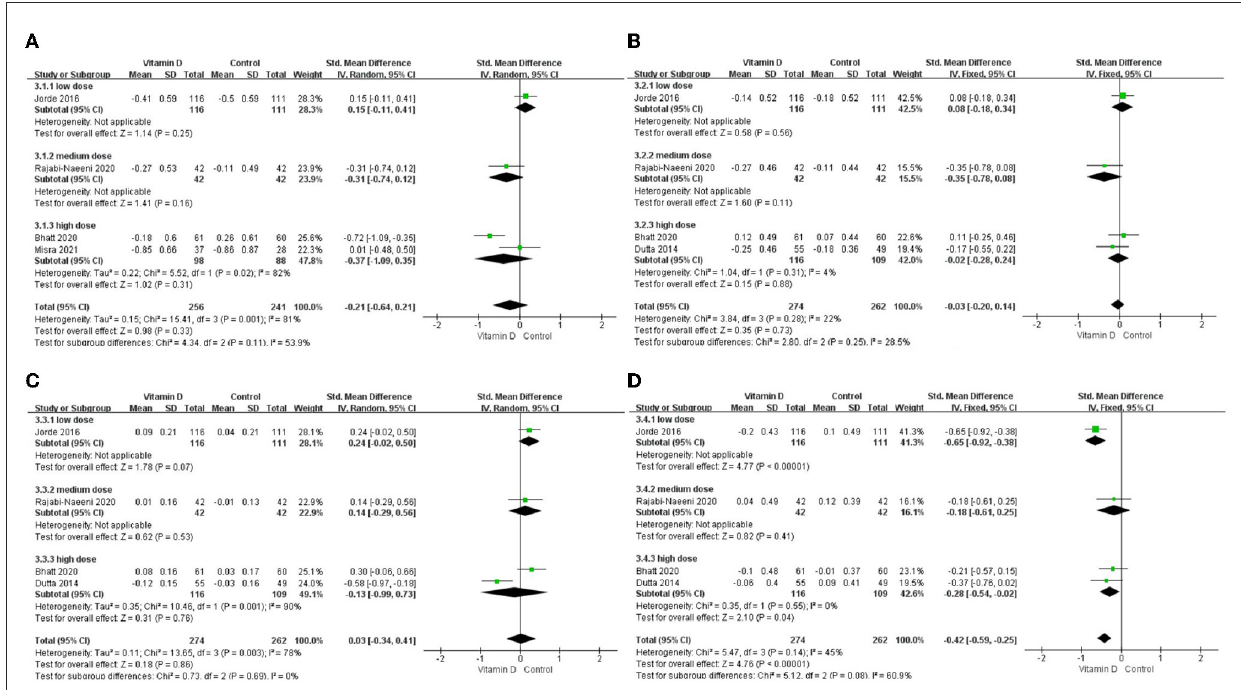
FIGURE6 Subgroup analysis by intervention dose. (A) TC, (B) LDL-C, (C) HDL-C, and (D) TG. TC, total cholesterol; LDL-C, low-density lipoprotein cholesterol; HDL-C, high-density lipoprotein cholesterol; TG, triglyceride.